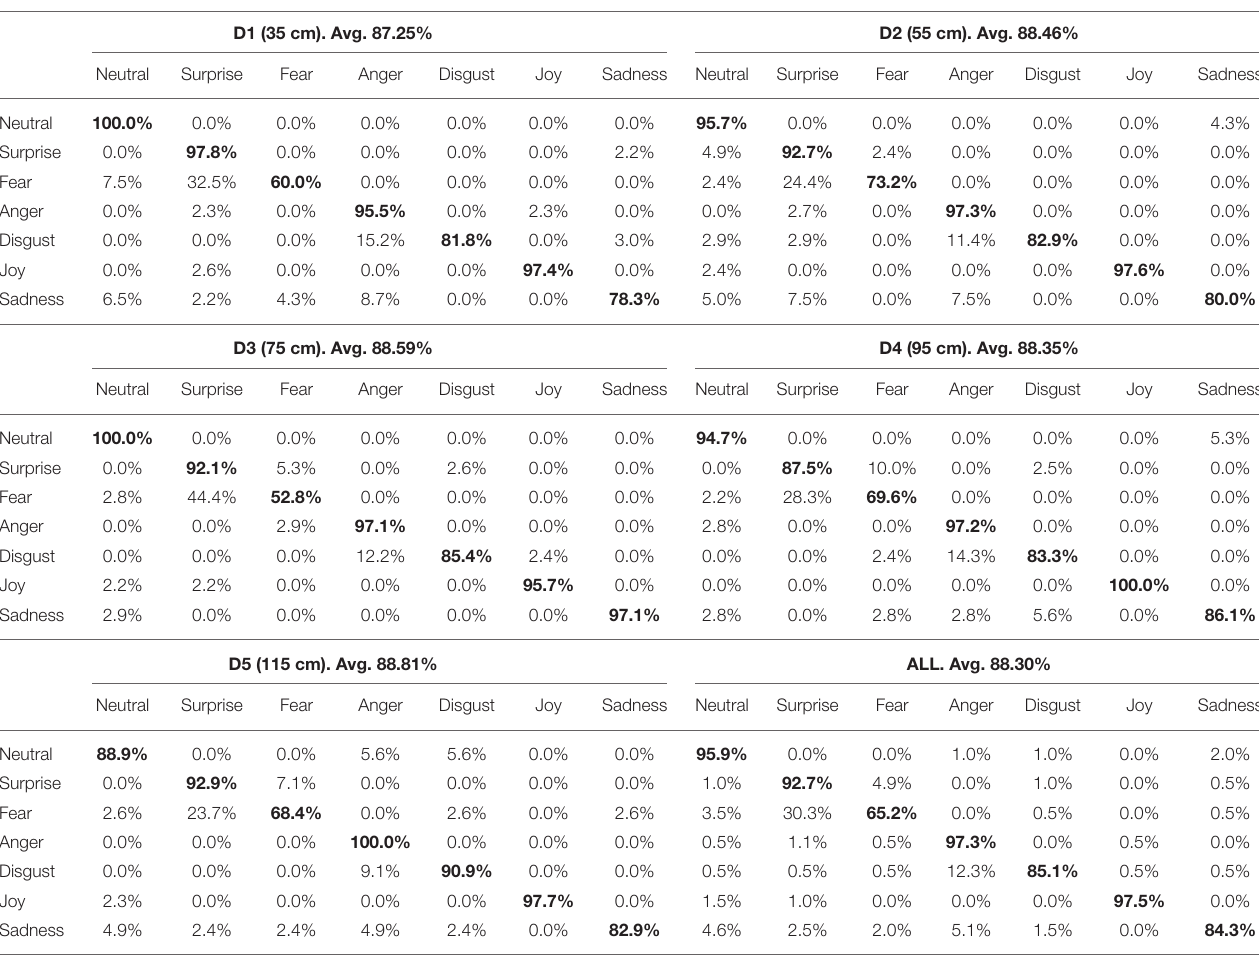
TABLE 5 | Emotion recognition rates and average values of the SIDE views for each interpersonal distance.